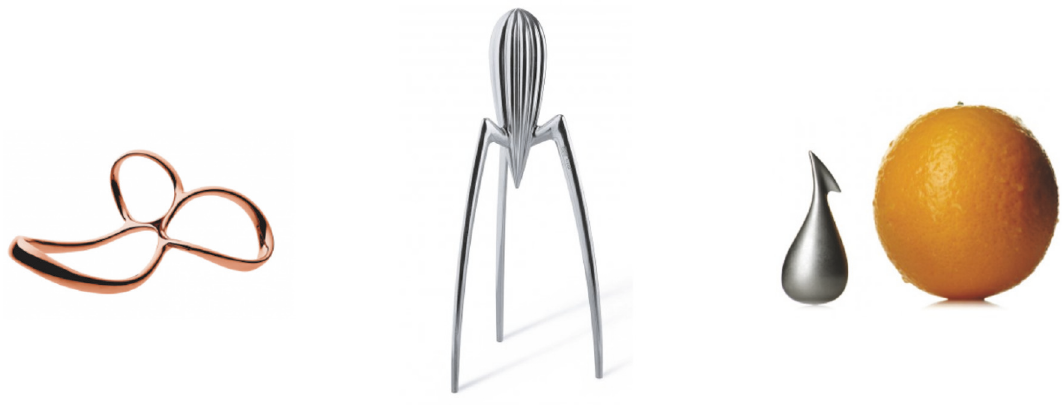
Figure 2: Three well-known Alessi products.